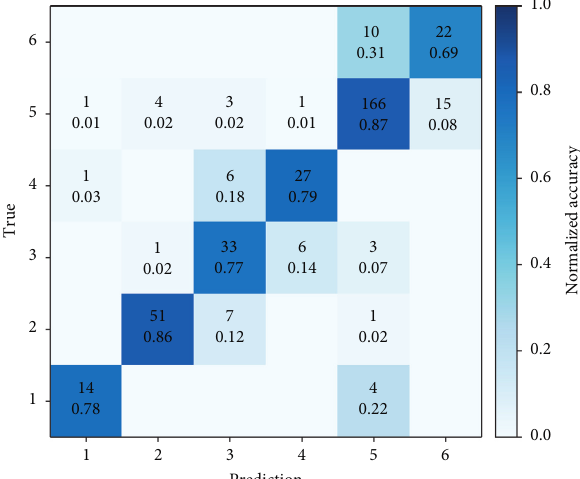
Figure 6: Confusion matrix for the Random Forest classification using 10 features from the training dataset. Each cell shows the number and the fraction of data points of a certain class which are assigned to a particular predicted class. Fractions in the diagonal are the recall